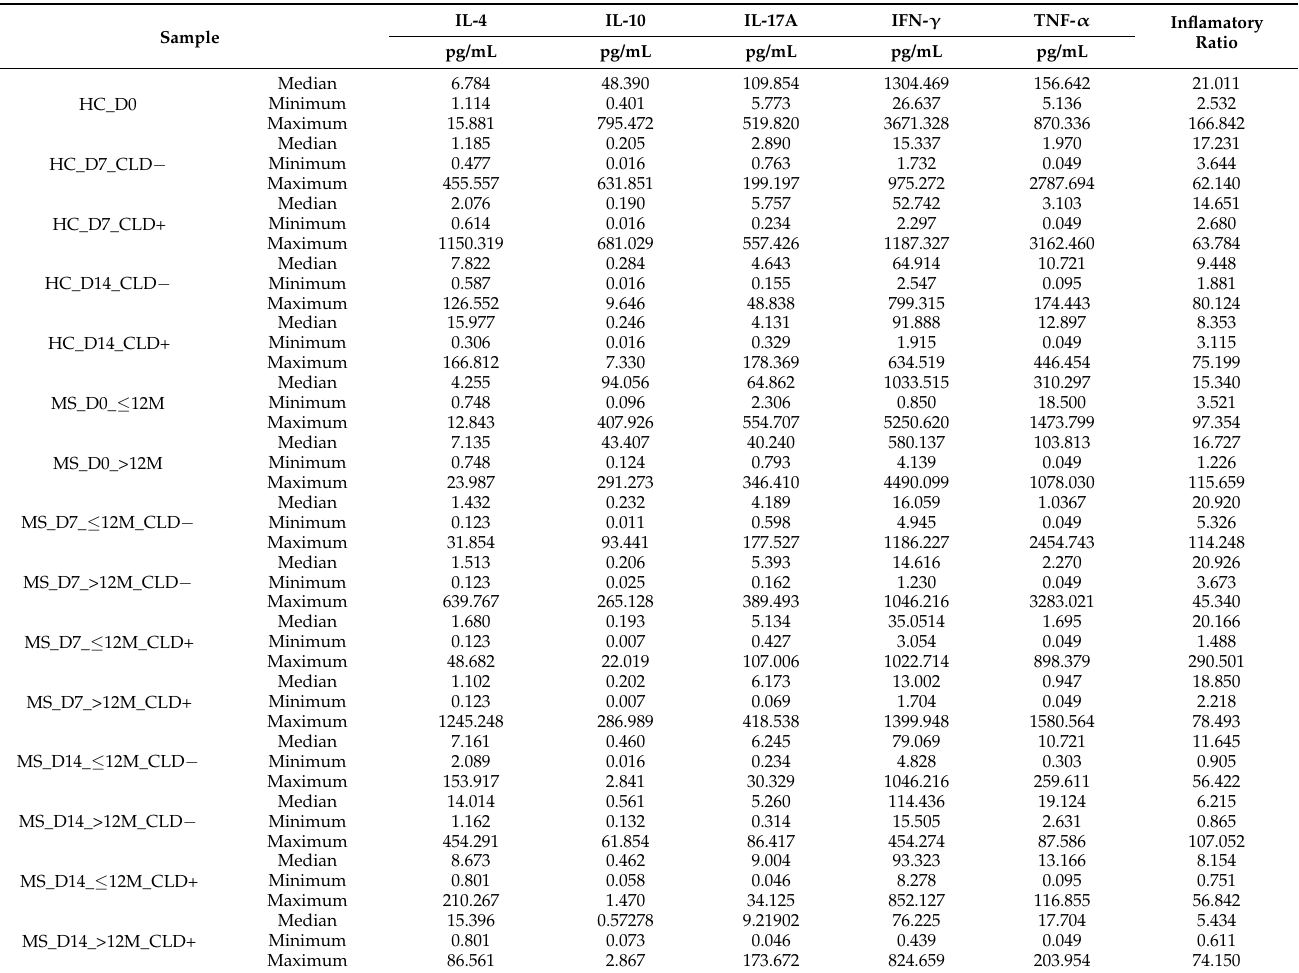
Table 2. Descriptive cytokine statistics and the inflammatory ratio for HCs and RRMS patients grouped by disease duration ( ≤ 12 and >12 months) at PBMC collection (D0) and on days 7 (D7) and 14 (D14) with (+) and without ( − ) CLD